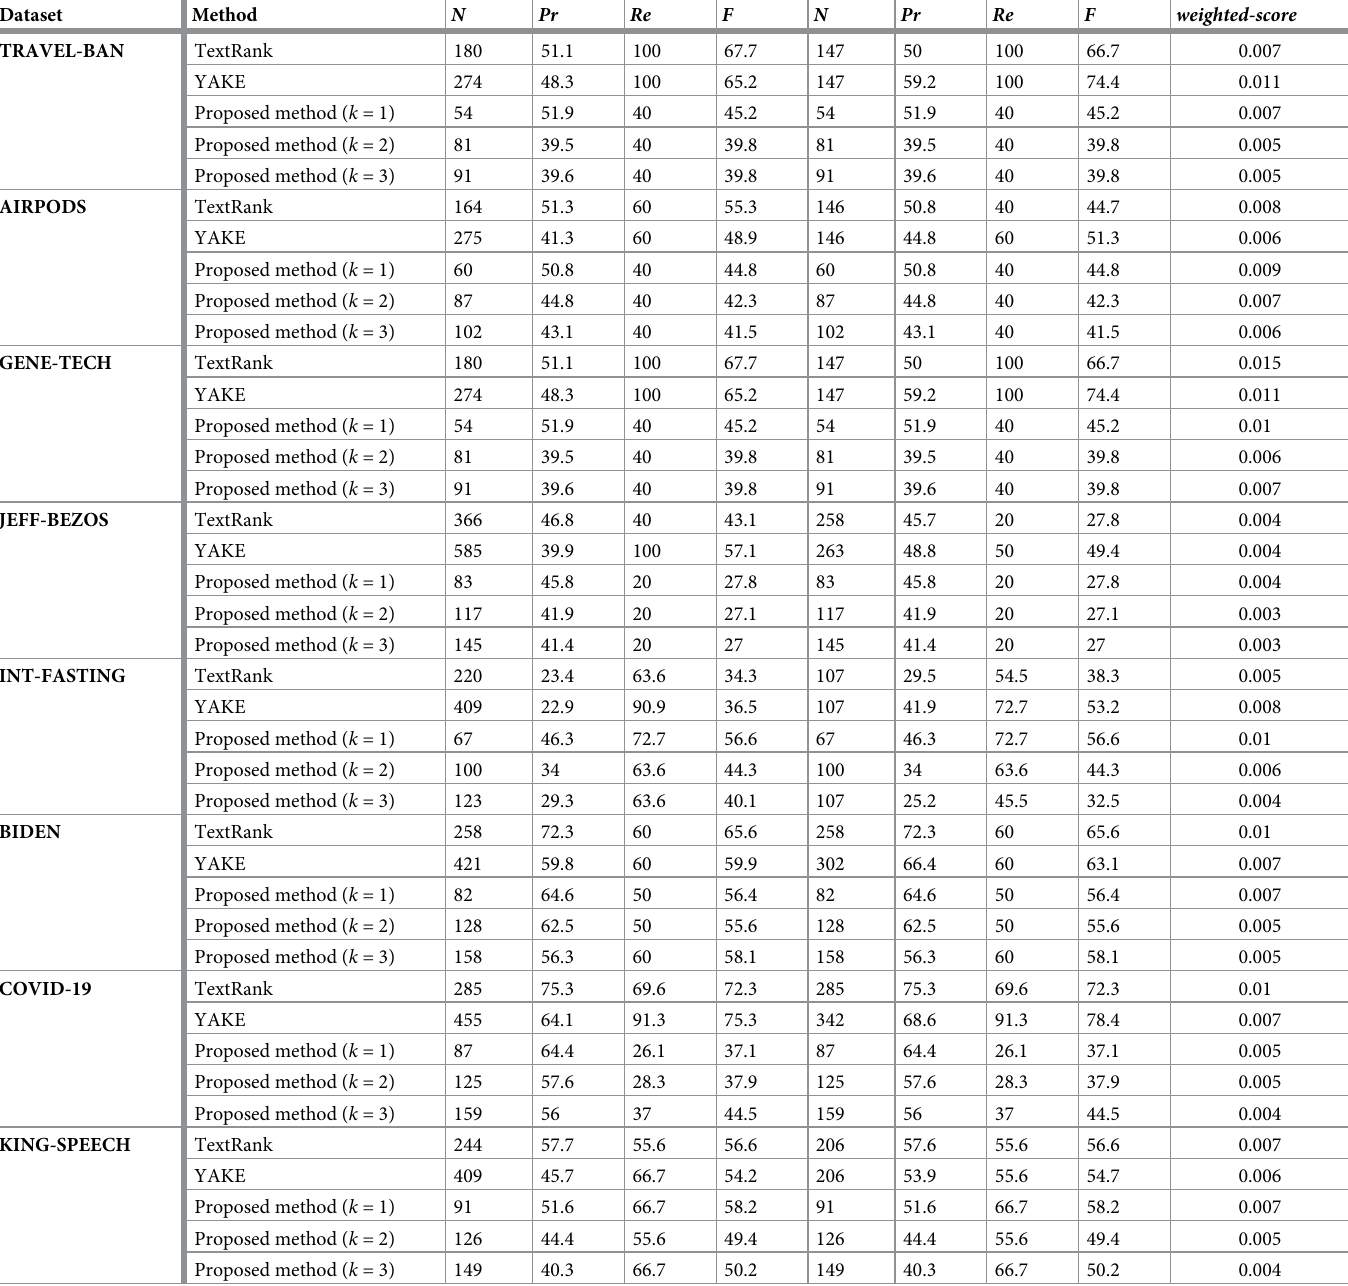
Table 7. Comparison of multiple keyword extraction